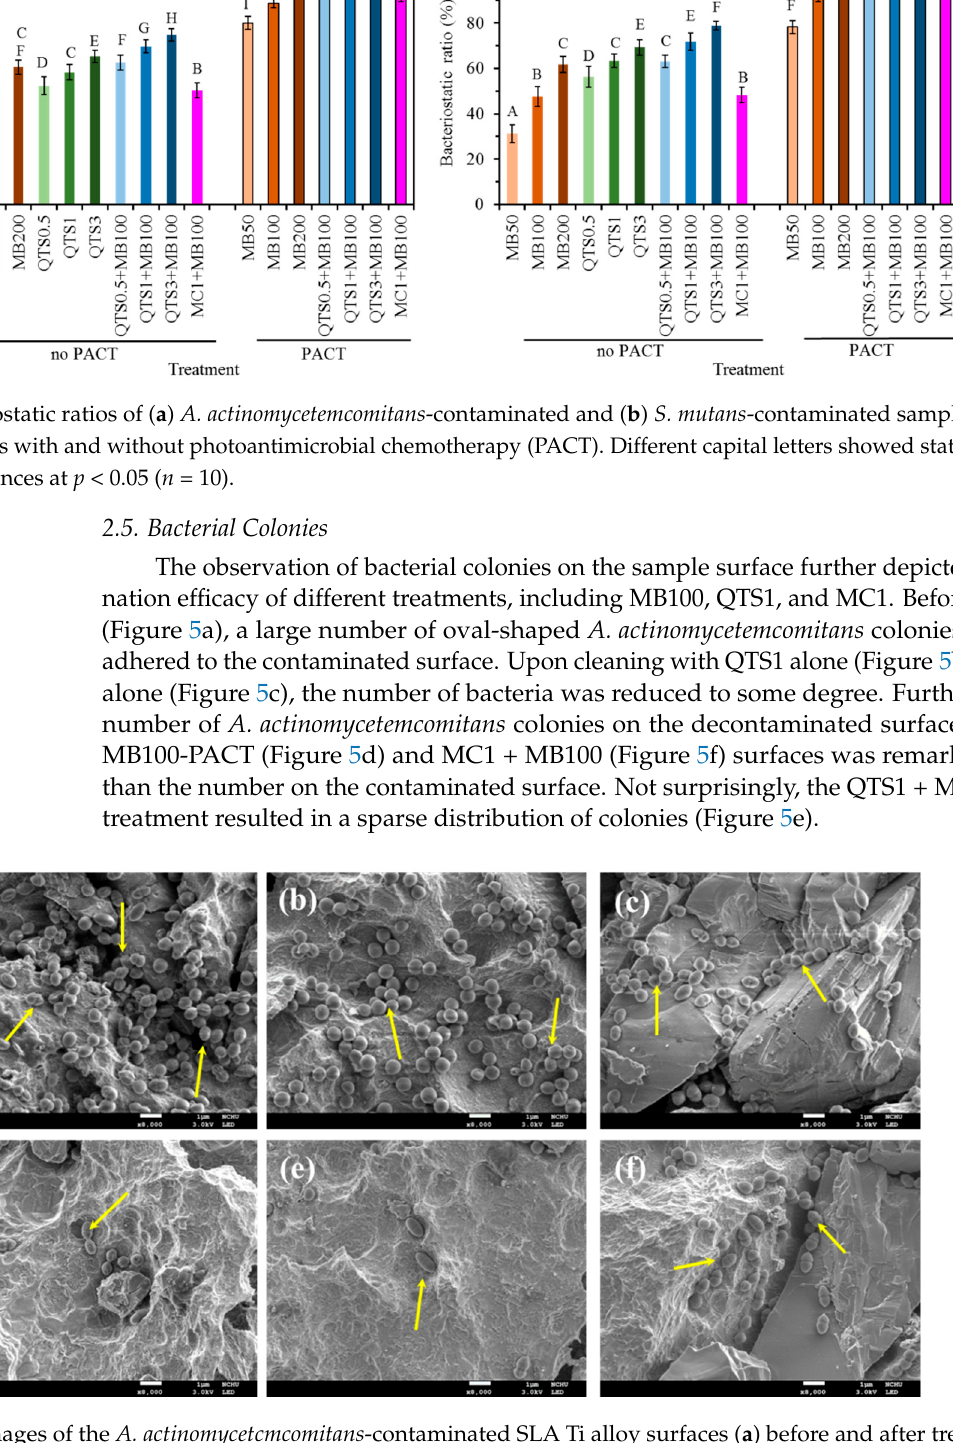
Figure 5. SEM images of the A. actinomycetcmcomitans -contaminated SLA Ti alloy surfaces ( a ) before and after treatment with ( b ) QTS1 alone, ( c ) MB100 alone, ( d ) MB100-PACT, ( e ) QTS1 + MB100-PACT, and ( f ) MC1 + MB100-PACT. The arrows indicate the presence of